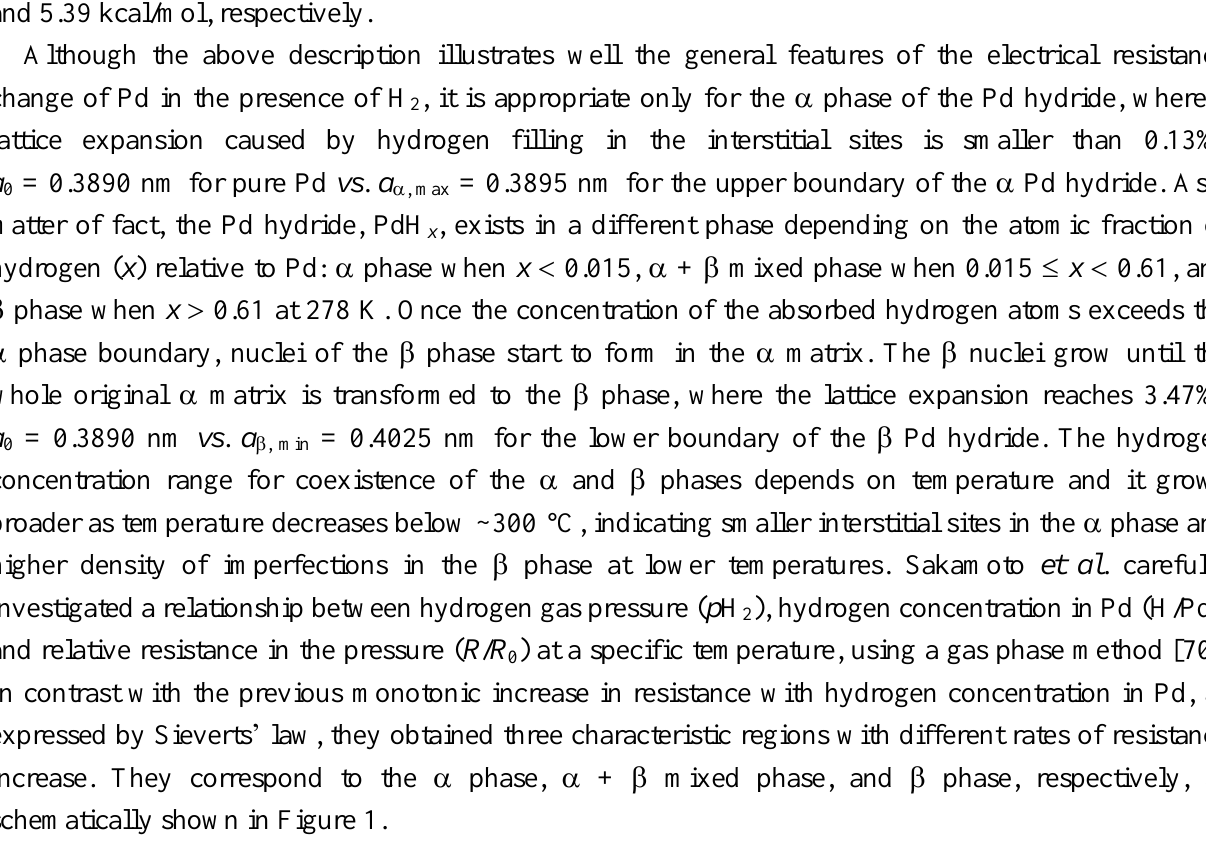
) as a function of relative 0